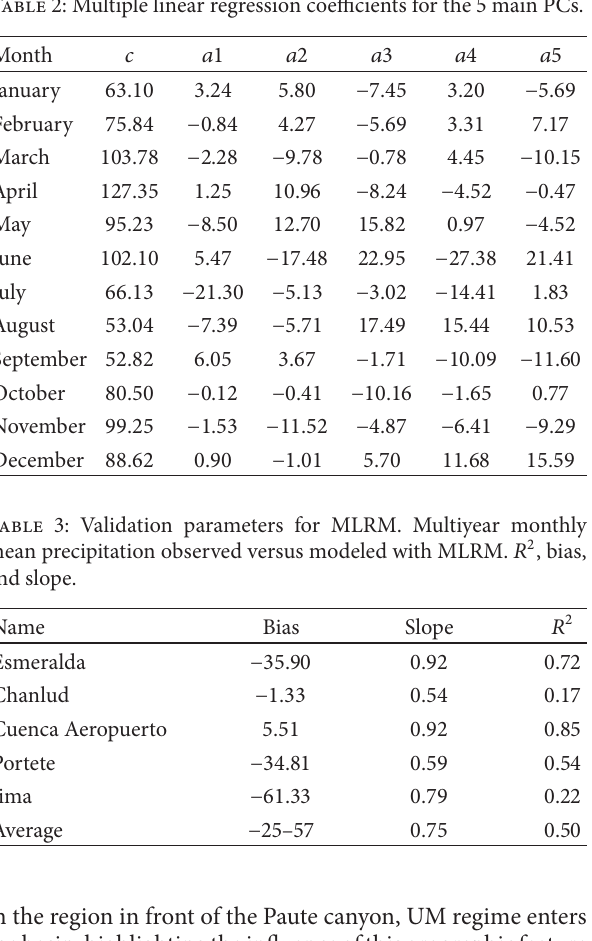
Table 4: CFM regression coefficients for the 3 main PCs.